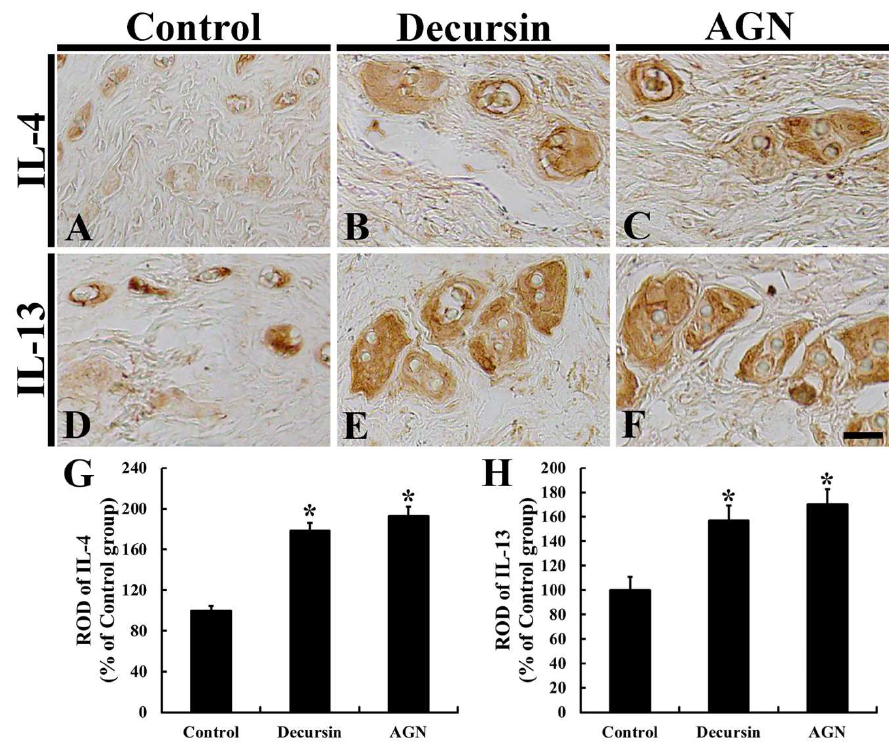
Figure 6. Immunohistochemistry for IL-4 ( A – C ) and IL-13 ( D – F ) in the dorsal skin of the control ( A , D ), decursin ( B , E ) and AGN ( C , F ) groups at 17 days. Regarding the decursin and AGN groups, significantly enhanced immunoreactivities of both IL-4 and IL-13 are found compared to those in the control group. Scale bar = 40 µ m. ( G , H ) ROD of IL-4 ( G ) and IL-13 ( H ) ( n = 10 in each group; * p < 0.05 versus control group). The bars indicate the means ± SEM.